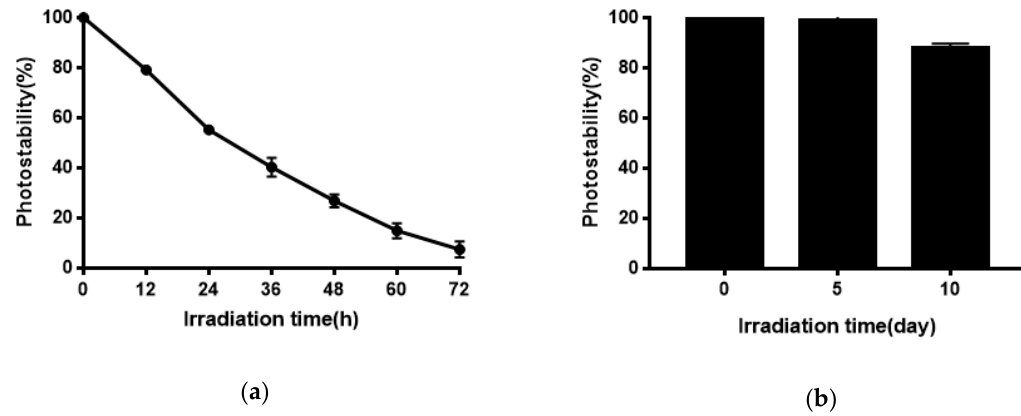
Figure 8. ( a ) Photostability of Quercetin solution; ( b ) the photostability of Quercetin-niosomes.